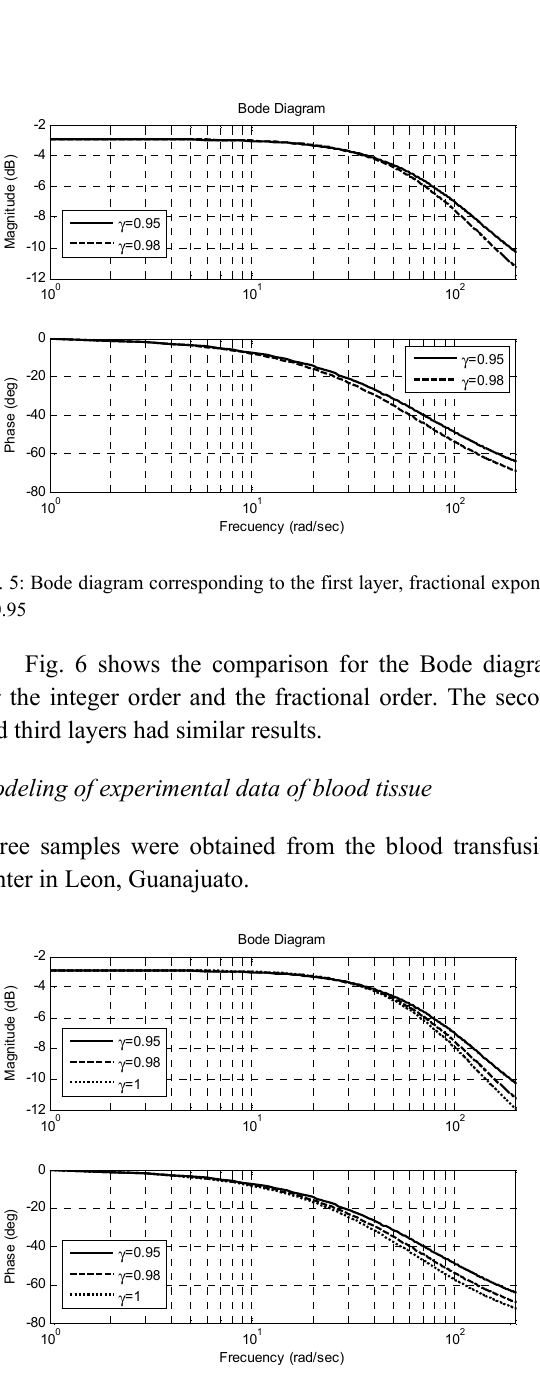
Fig. 6: Bode diagram comparison corresponding to the first layer, integer order and fractional exponent γ =0.95 and γ =0.98.